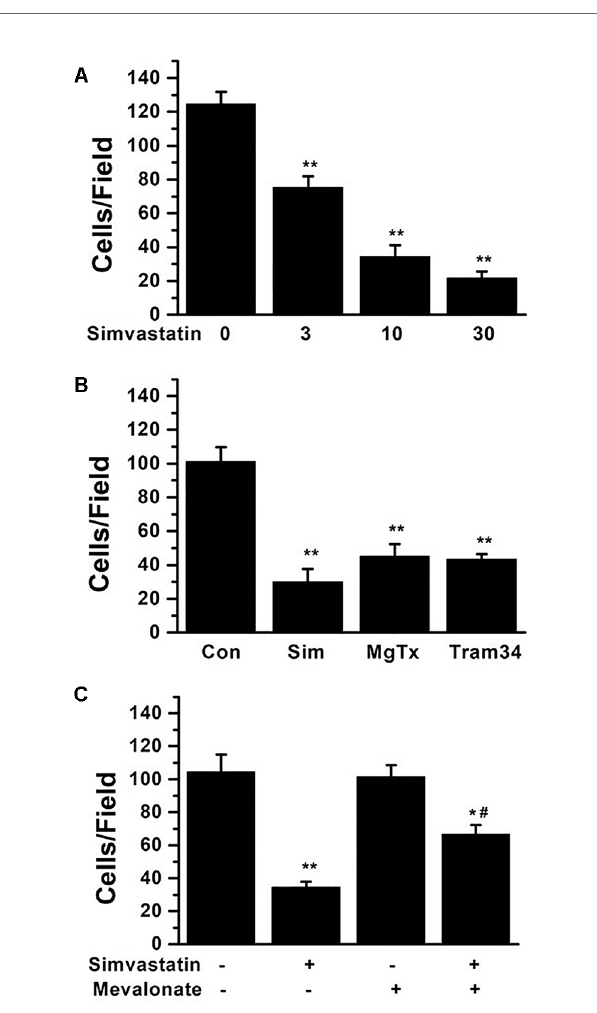
FIGURE 6 | THP-1 cell migration induced by 2 nM MCP-1 was determined by immunocytochemistry in transwell cell chambers. (A) THP-1 cells were seeded and incubated with 0, 3, 10, or 30 µM simvastatin. The summarized data from at least 5 duplicates was expressed as mean ± SEM. ** P < 0.01, vs. 0 µM simvastatin. (B) 10 µM simvastatin, 1 nM MgTX, and 1µM Tram-34 treatments signi fi cantly inhibited cell migration compared with controls, ** P < 0.01; n = 8 for each group. (C) THP-1 cells were treated using 10 µM simvastatin with or without 100 m M mevalonate application, * P < 0.05 and ** P < 0.01, vs. controls group without either simvastatin or mevalonate, # P < 0.05, vs. group with simvastatin only; n = 8 for each